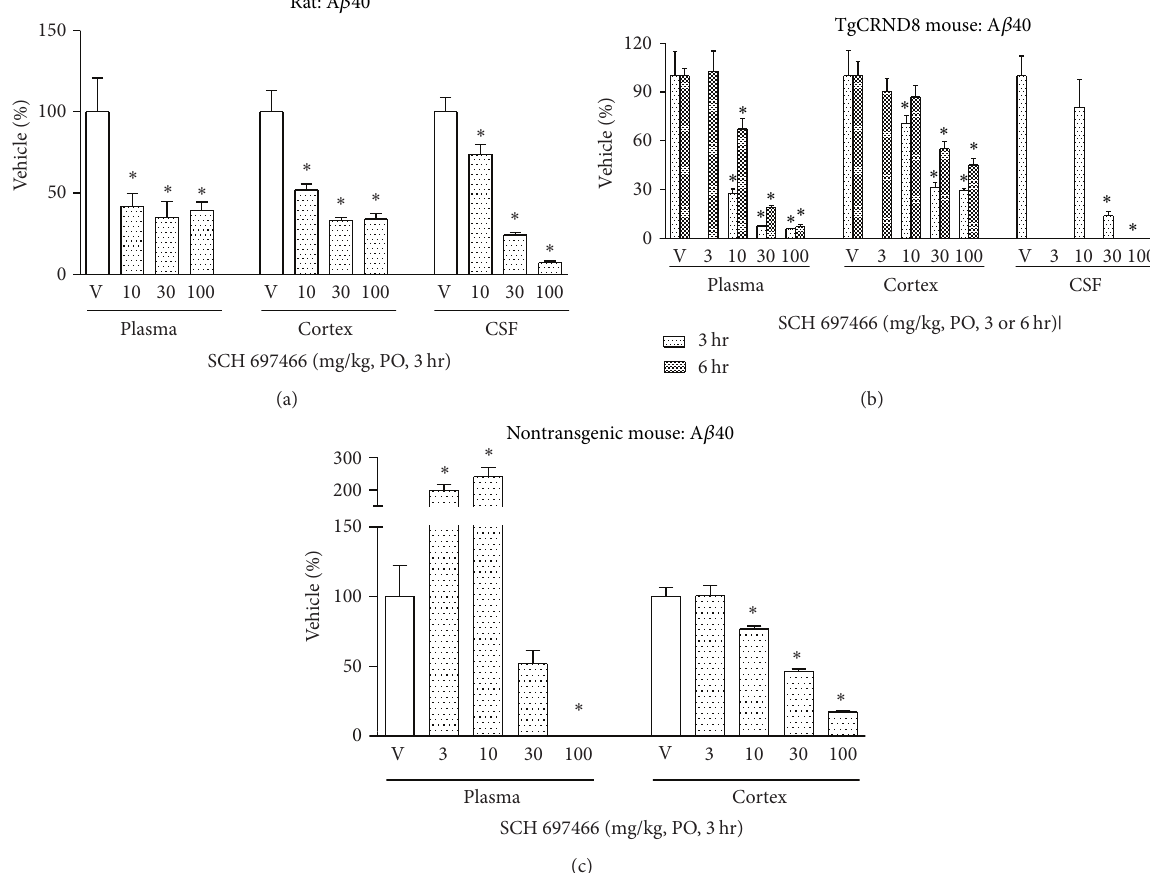
cortex A 𝛽 42 by 80% and 42%, respectively. compared to 89% and 82% for plasma and cortex A 𝛽 40. There was a